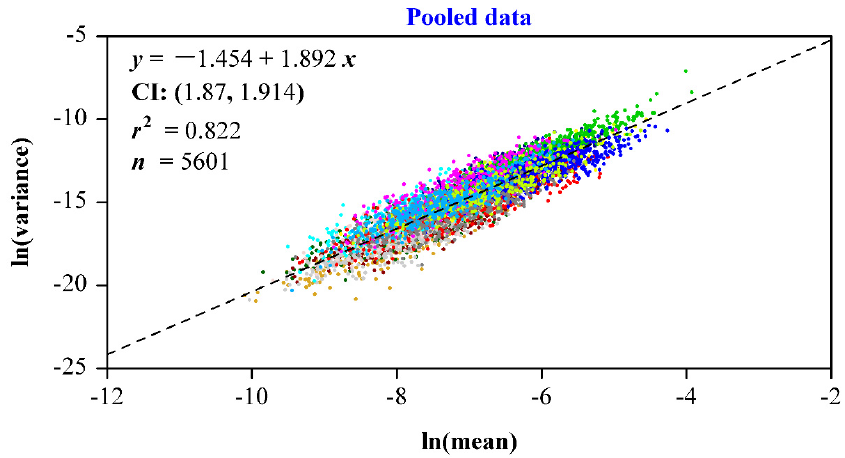
Figure 8. Scaling relationship between the mean and variance of leaf bilateral symmetry measure for the pooled data of 15 vines. y represents the natural logarithm of variance; x represents the natural logarithm of mean; CI represents the 95% confidence intervals of the slope based on bootstrapping (3000 resamples); r 2 is the coefficient of determination, which measures the goodness of fit for a reduced major axis regression; and n is the sample size. Di ff erent colors represent di ff erent species of vines, and each point corresponds to a single